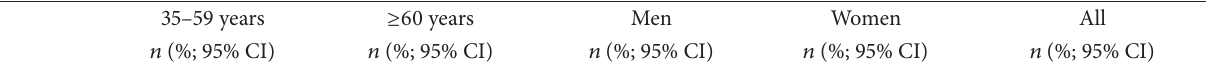
Table 2: The prevalence of age-related eye diseases in the study population.